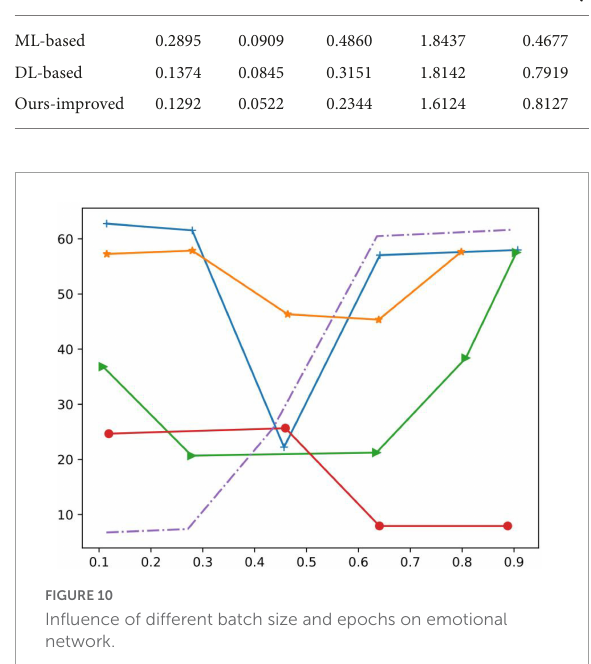
FIGURE10 Influence of different batch size and epochs on emotional network.